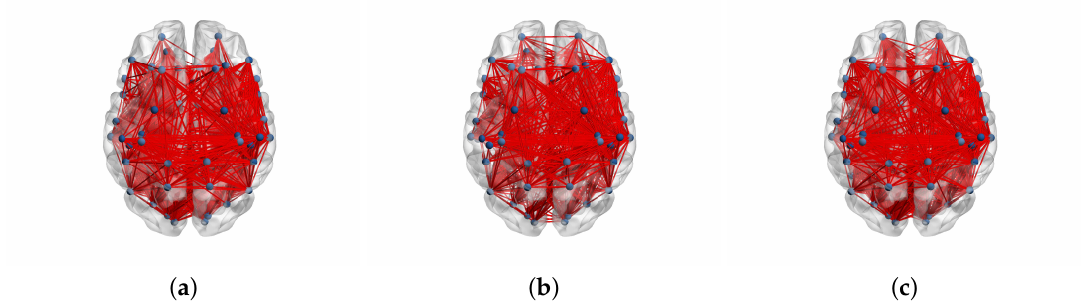
Figure 5. Connections between ROIs for 64 electrodes of: ( a ) CNT, ( b ) MCI and ( c ) AD.